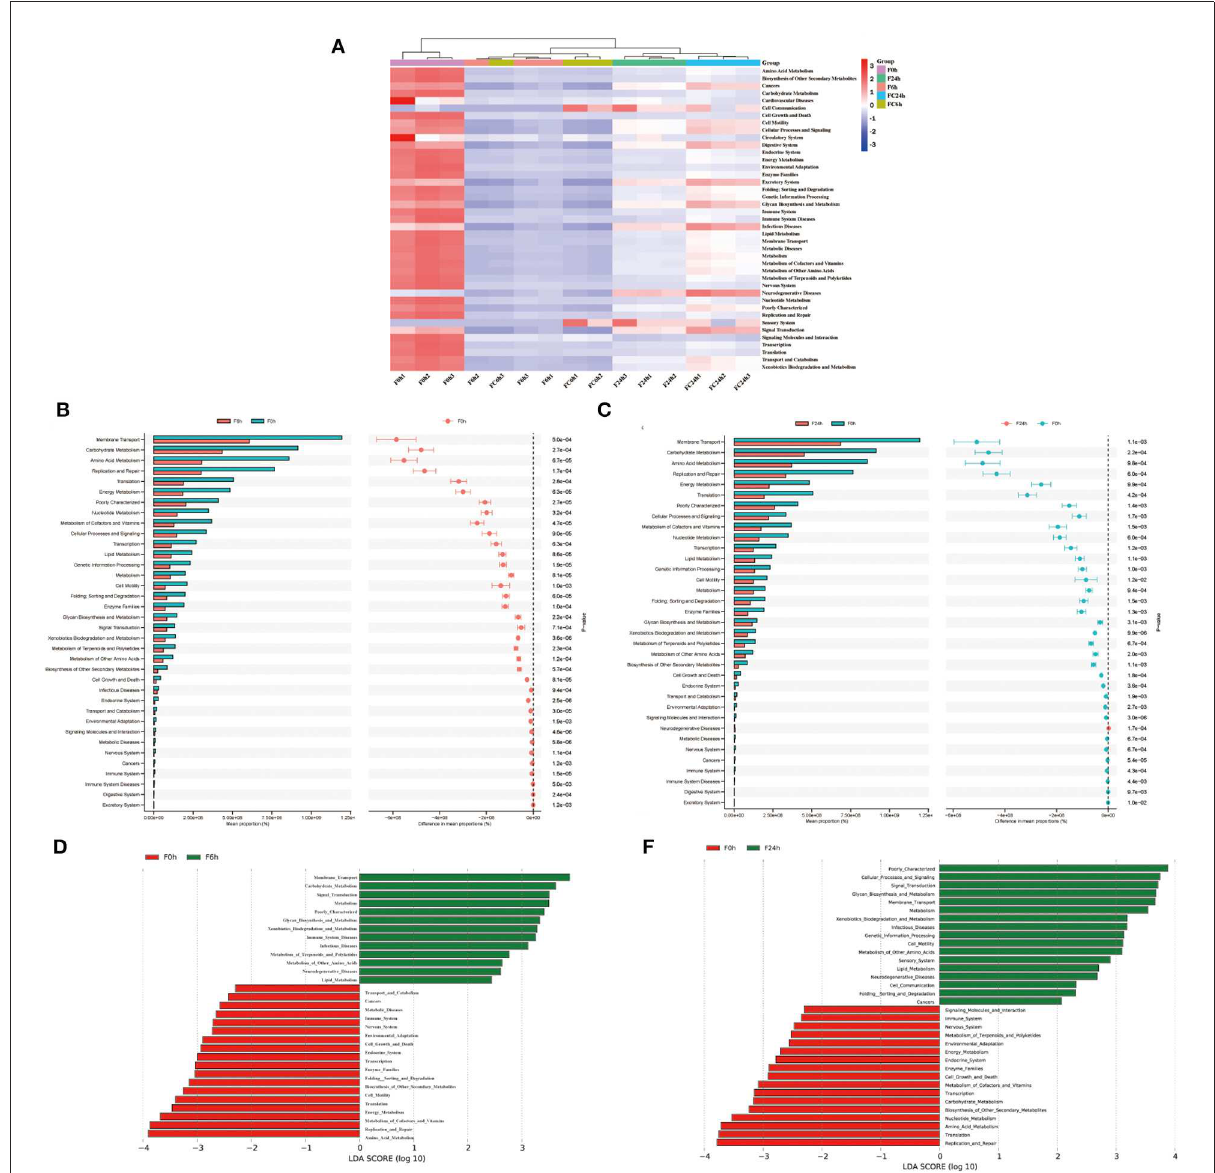
FIGURE10 KEGG pathway analysis. (A) The heatmap of clustering for KEGG pathways. (B,C) Analysis for KEGG pathway using STAMP of F6h and F24h compared to F0h. (D,E) Analysis for KEGG pathway using Lefse of F6h and F24h compared to